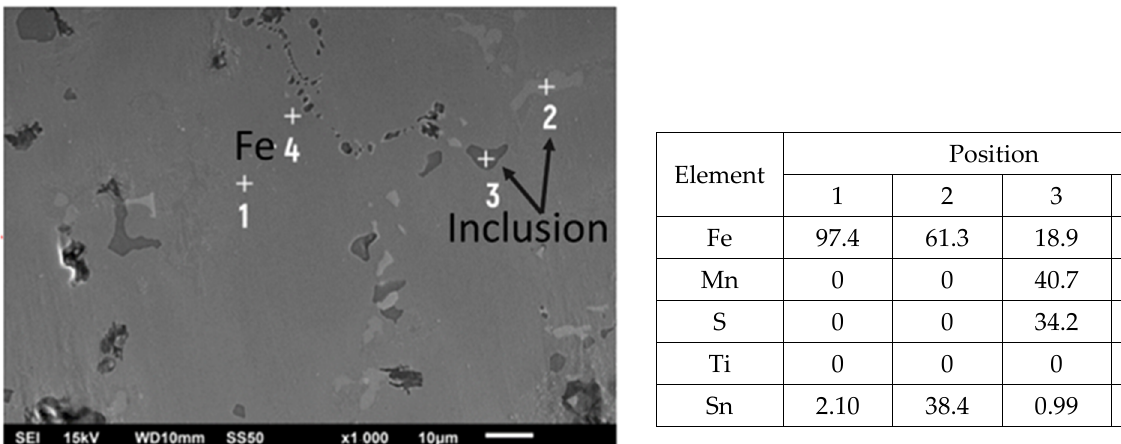
Figure 14. SEM EDS analysis secondary electron image and composition of iron granule from the carbothermic reduction of the ilmenite concentrate at 30% Na 2 CO 3 addition, initial temperature of 1300 ◦ C, final temperatures of 1500 ◦ C, and heating rate of 6.6 ◦ C/min (pattern